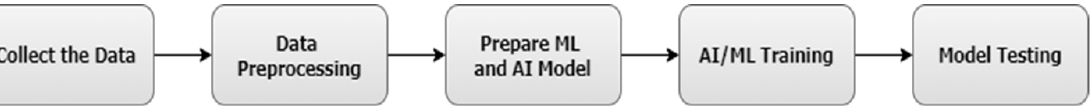
Figure 2. Flowchart for the research’s experiment, step by step.